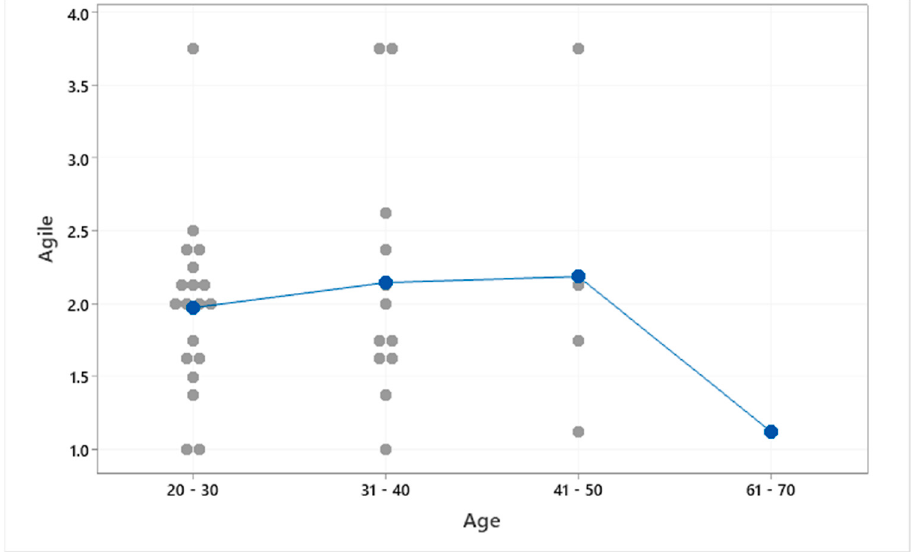
Figure 16. Individual value plot of agile vs. age .